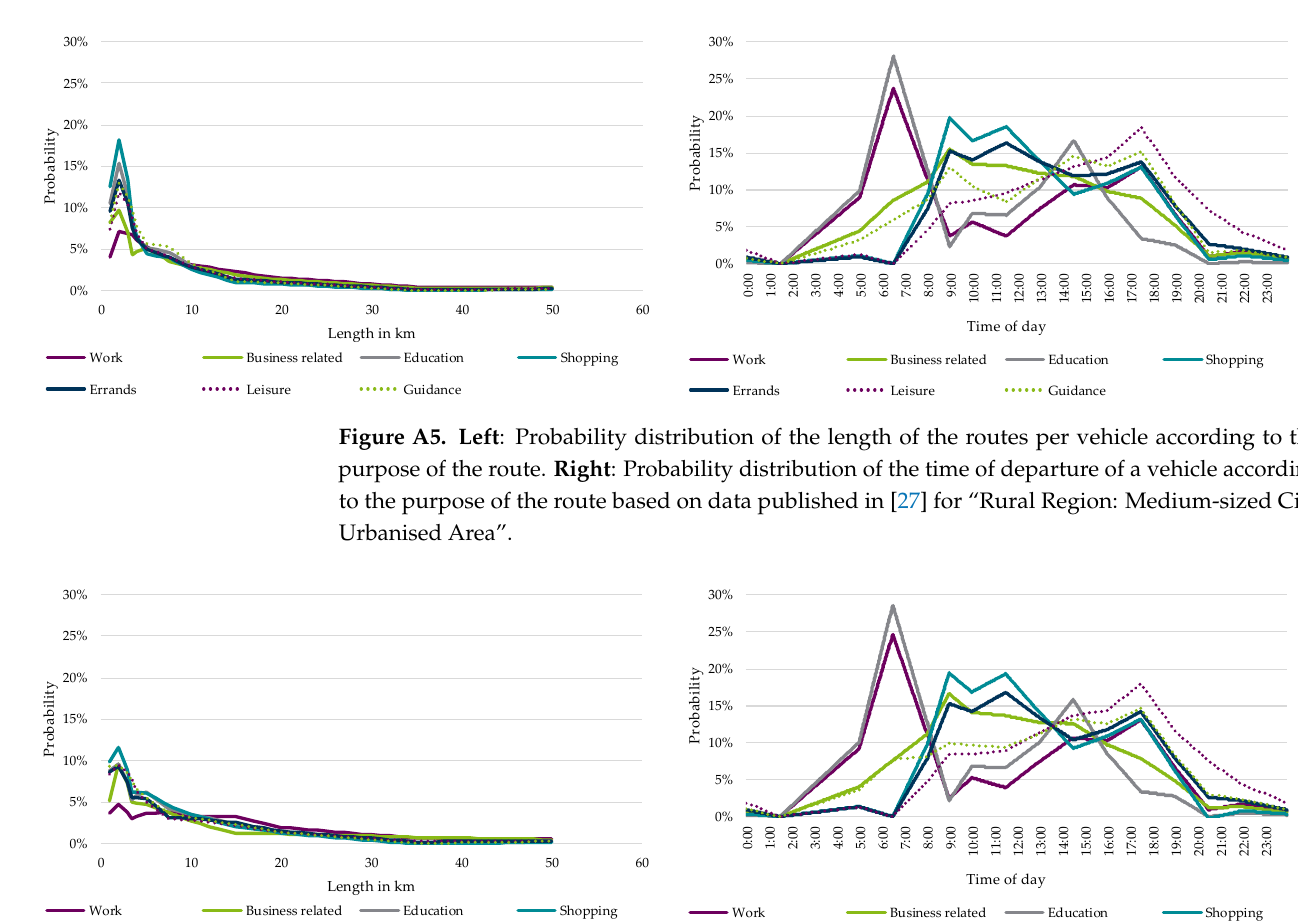
Figure A4. Left : Probability distribution of the length of the routes per vehicle according to the purpose of the route. Right : Probability distribution of the time of departure of a vehicle according to the purpose of the route based on data published in [27] for “Rural Region: Central City”.